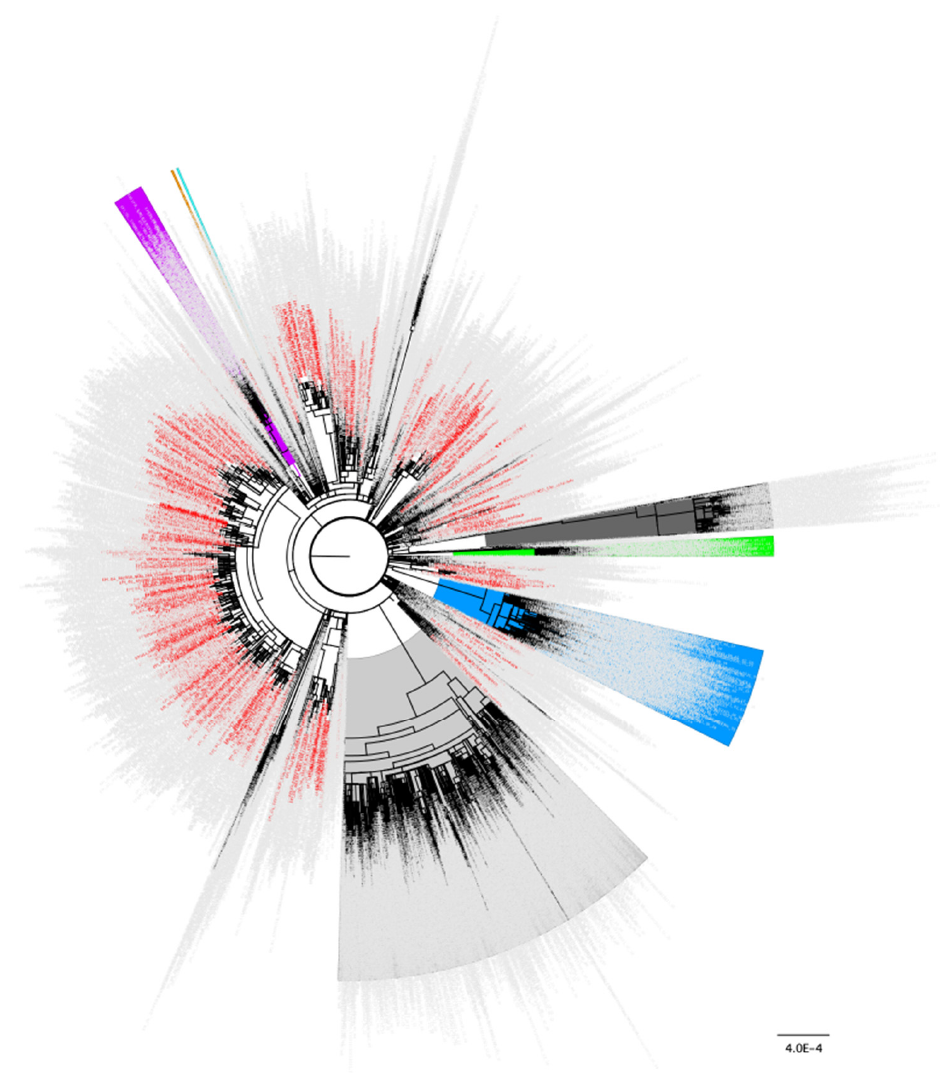
Figure 1. Distribution of the 834 samples containing Spike N501Y as a minor variant from October 2020 across the global SARS-CoV-2 phylogeny indicating independent emergence. Background lineages include Alpha/B.1.17 samples highlighted in blue, Gamma/P.1 highlighted in green, Beta/B.1.351 highlighted in purple, Epsilon/B.1.429 highlighted in orange, Iota/B.1.526 highlighted in turquoise, Delta/B.1.617.2 highlighted in grey, and Omicron/BA.1/BA.2 highlighted in dark grey. None of the 834 samples containing Spike N501Y as a minor variant in October 2020 were present in these highlighted lineages. Non VoC/VoI lineages are not highlighted. 834 samples identified as having the N501Y change present as a minor variant in October 2020 (Table 1) are colored in red. 3243 total background genomes were included in this analysis.